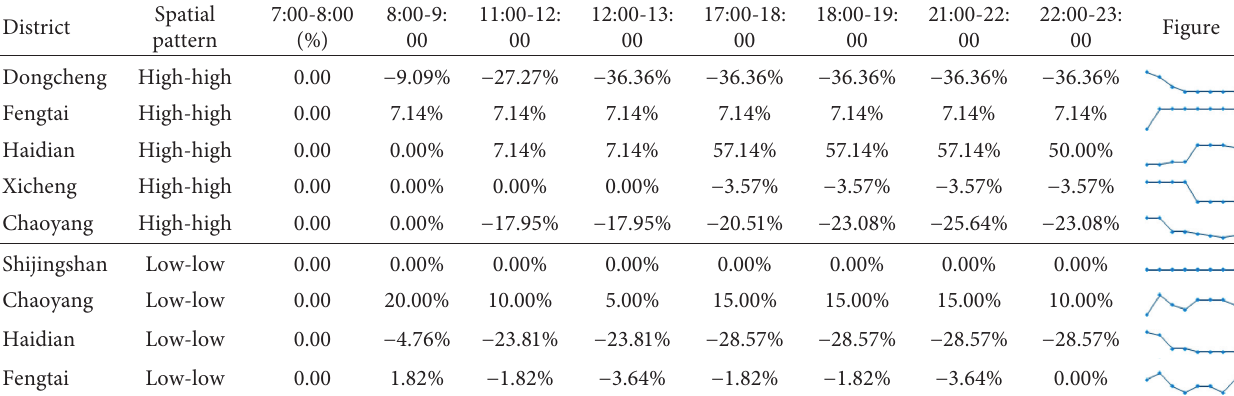
Table 7: Changes of aggregation frequency result in administrative